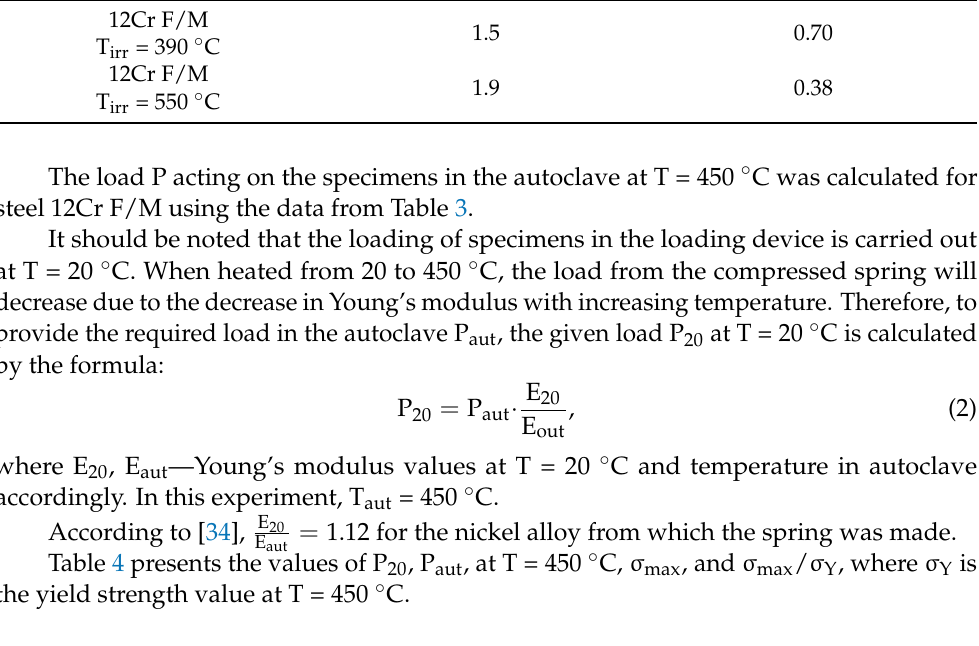
Table 3. The values of the parameter k p in Equation (1).